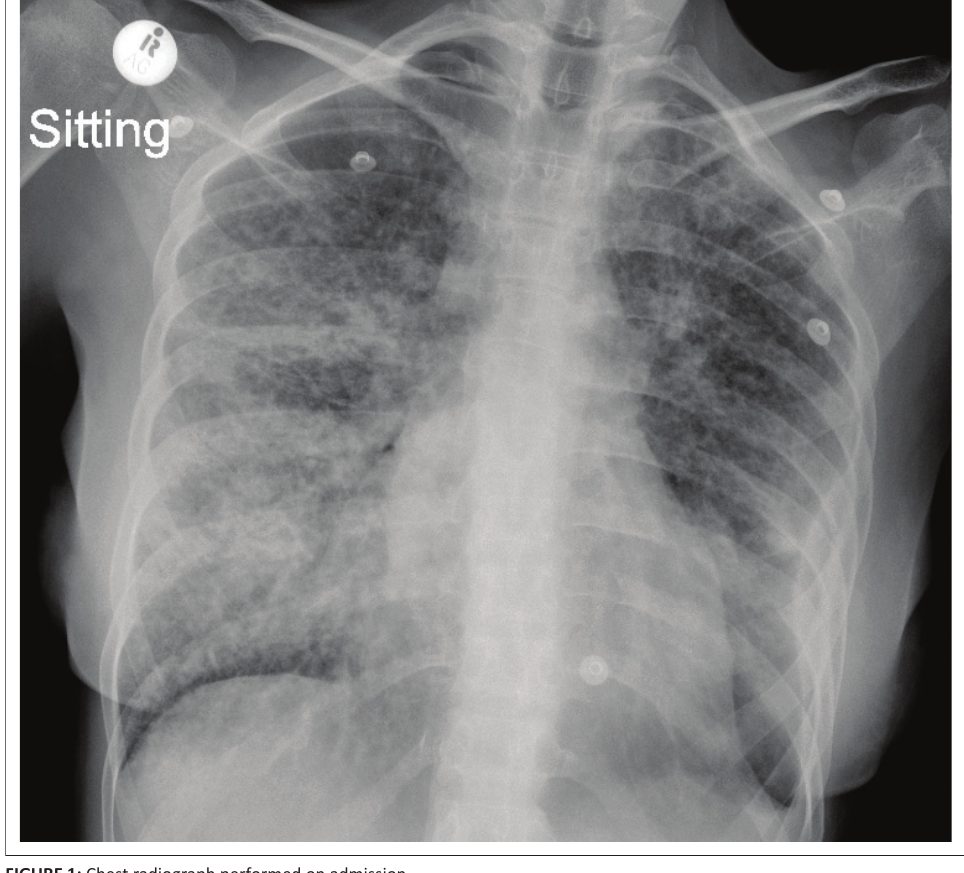
FIGURE 1: Chest radiograph performed on